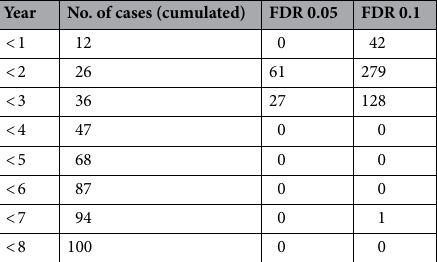
Year No. of cases (cumulated) FDR 0.05 FDR